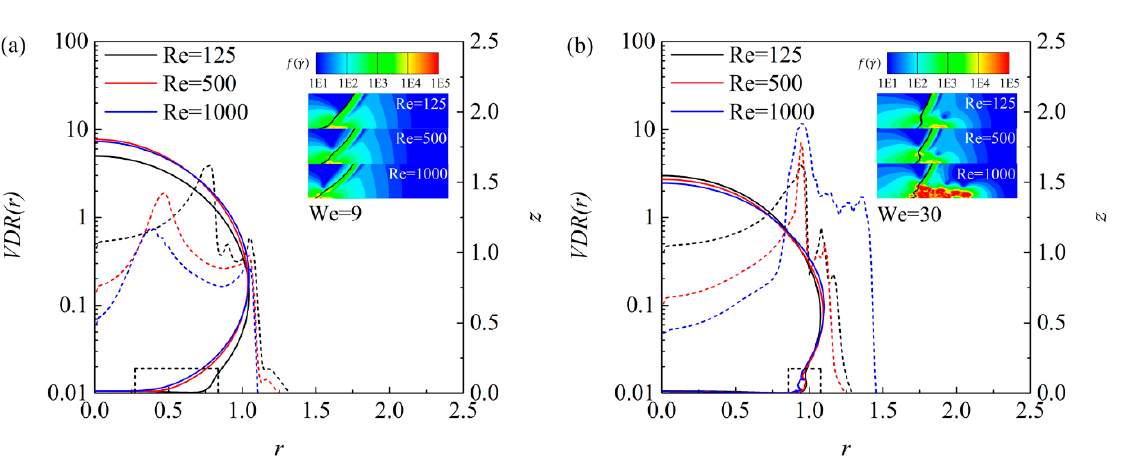
Figure 11. Comparison of 𝑉𝐷𝑅(𝑟) for droplet spreading under three different Reynolds numbers ( a ) We = 9 and ( b ) We = for ( a ) 𝑊𝑒 = 9 and ( b ) 𝑊𝑒 = 30 .